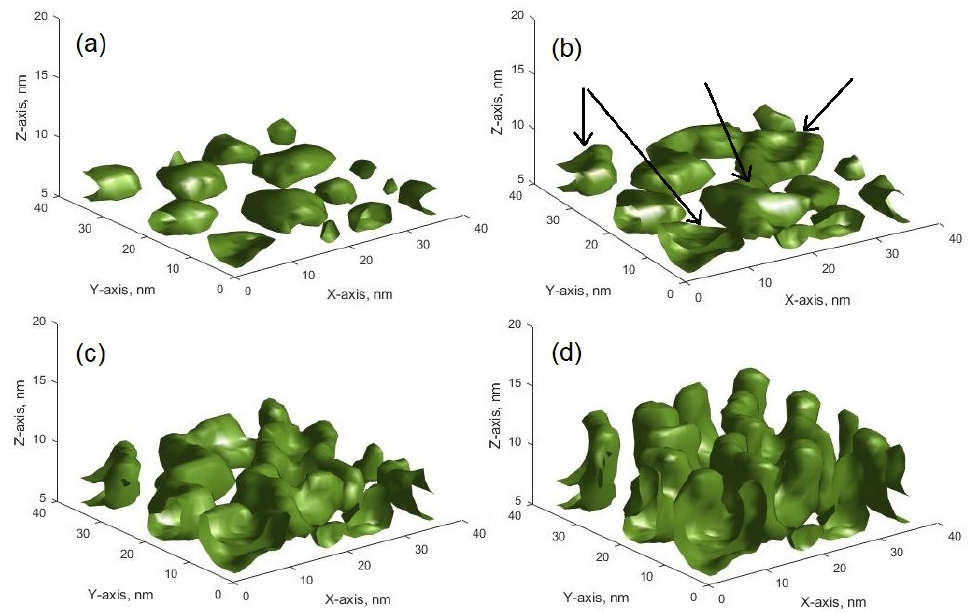
Figure 7. Three-dimensional plots of nanoclusters made of component A observed at different growth times. The growth times were as follows: 0.1T ( a ), 0.2T ( b ), 0.3T ( c ), and 0.5T ( d ).